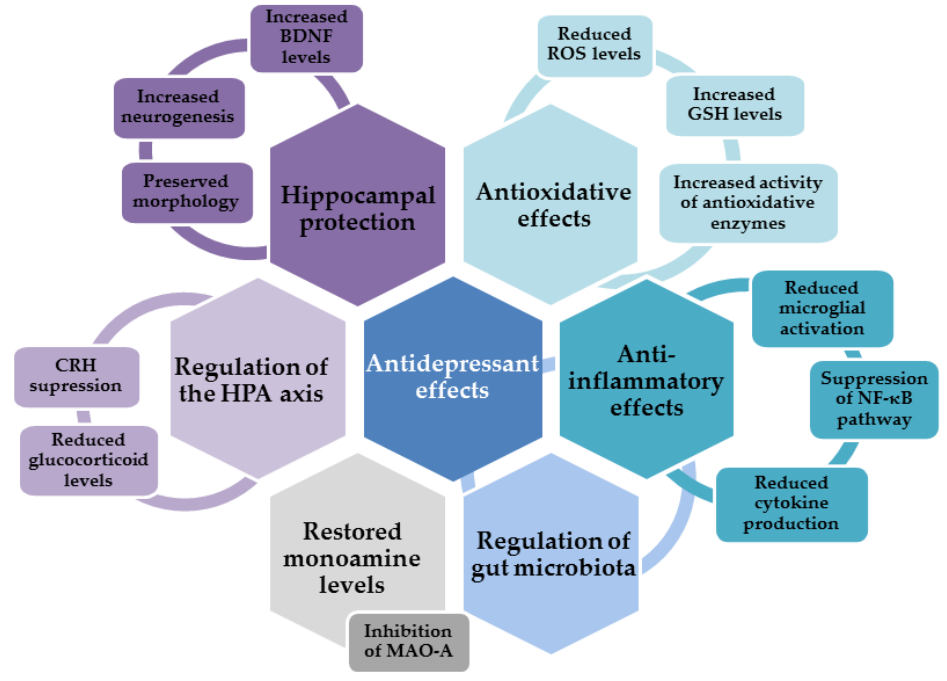
Figure 2. The main mechanisms contributing to antidepressant effects of quercetin and other flavo-